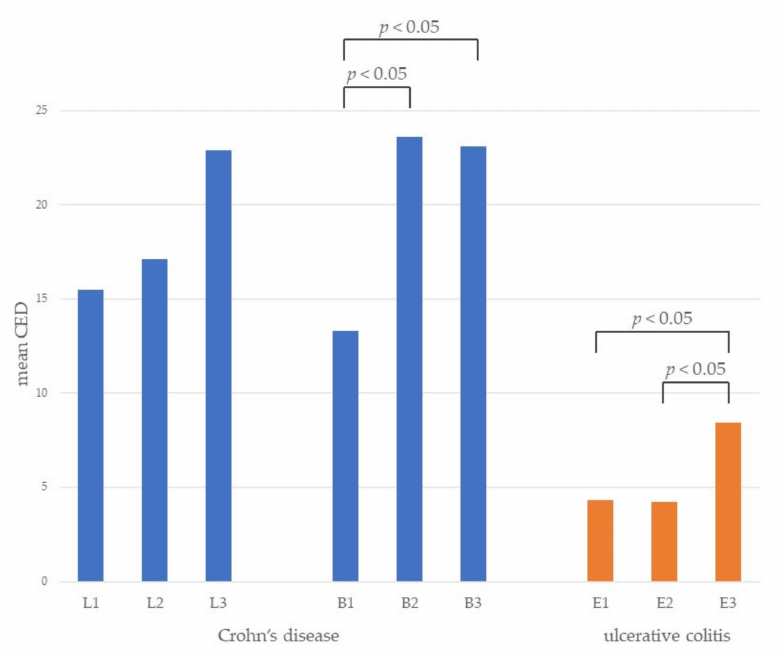
Figure 4. Mean cumulative effective dose (CED) in different location and behavior of Crohn’s disease and extension of ulcerative colitis. L1—ileal, L2—colonic, L3—ileocolonic, B1—non- stricturing/non-penetrating, B2—stricturing, B3—penetrating, E1—ulcerative proctitis, E2—left- sided colitis, E3—extensive colitis, p < 0.05 (B1 to B2 and B3; E3 to E1 and